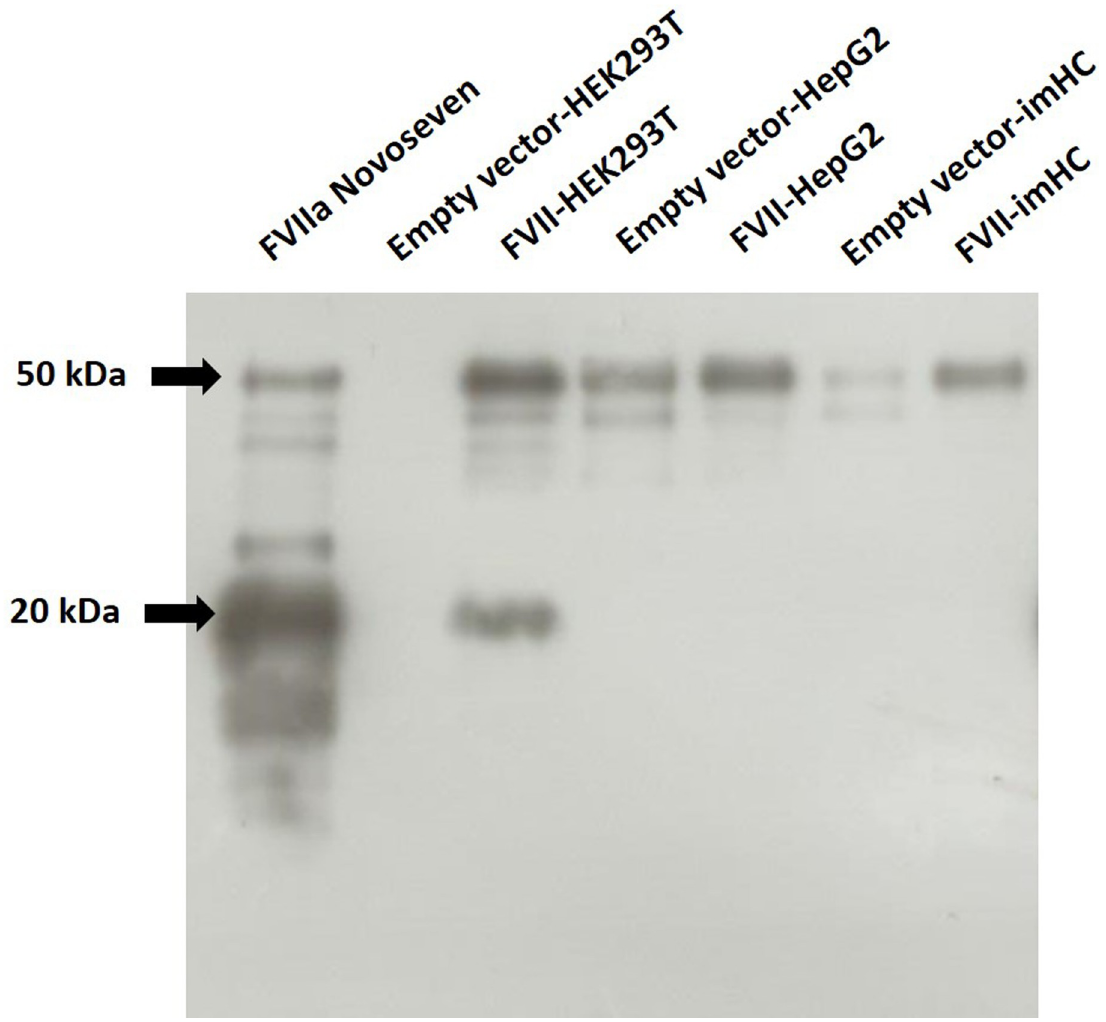
Fig 4. Western blot analysis of FVII in culture media supernatant. Western blot analysis of protein samples from the culture media supernatant from the indicated lanes (10 μ g and 1 μ g of total proteins were used for empty vector constructs and FVII constructs, respectively). Recombinant FVIIa (Novoseven, 500 ng) was used as a positive control. The zymogen FVII (MW * 50 kDa) and the light chain of the protease FVIIa (MW * 20 kDa) are marked with arrows.